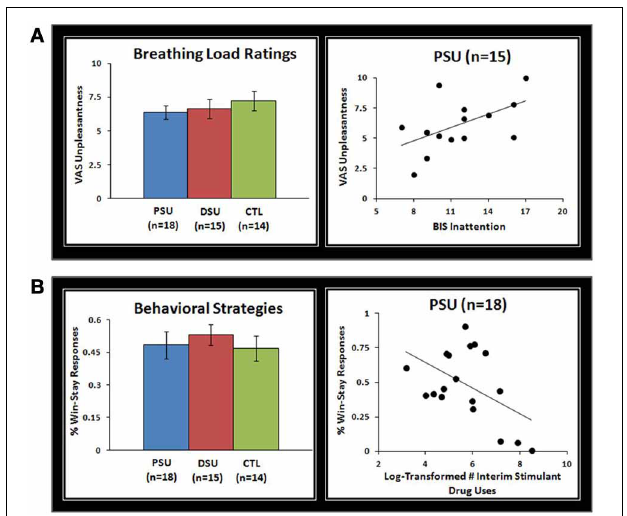
FIGURE 4 | (A) Although problem stimulant users (PSU), desisted stimulant users (DSU), and healthy comparison subjects (CTL) did not differ on visual analogue scale (VAS) unpleasantness ratings of the breathing load stimuli, within PSU higher Barratt Impulsivity Scale (BlS) Inattention scores were associated with higher VAS unpleasantness ratings. Three PSU subjects did not have BIS scores and therefore were not included in scatterplots. (B) Although groups did not differ in percentage of win-stay responses across error-rates, within PSU a greater frequency of stimulant drug uses in the past 3 year interim period was associated with a lower percentage of win-stay responses. Error bars indicate ± 1 standard